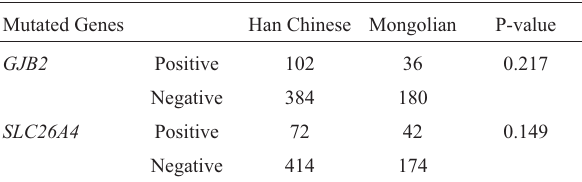
Table 3 - Frequency of the mutated alleles in the four deafness-related genes screened in Han Chinese and Mongolian ethic groups. Mutated Genes